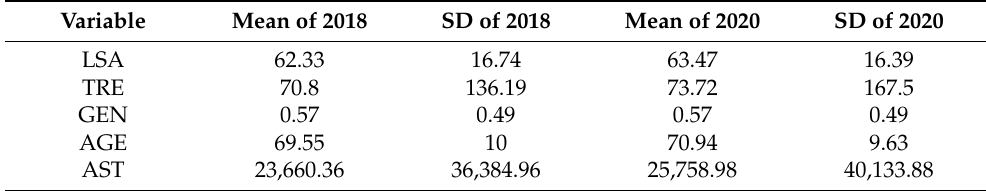
Table 2. Descriptive statistics (N = 2928 in 2018) (N = 2187 in 2020). Variable